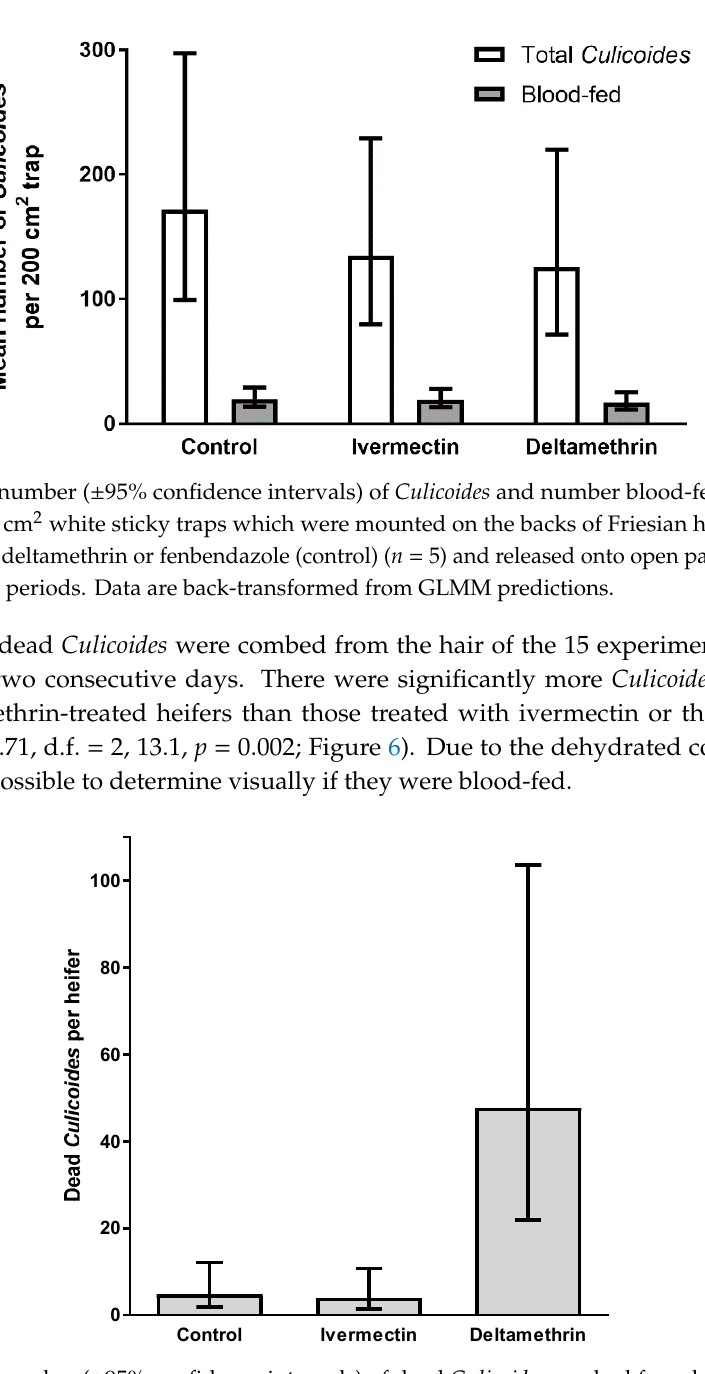
8 of 13 Figure 4. Mean number (±95% confidence intervals) of Culicoides and number blood-fed (grey bars) captured on 200 cm 2 white sticky traps mounted on the backs of Friesian heifers, treated with ivermectin and fenbendazole (control) ( n = 10) and released onto open pasture for 24 h. Data are back- transformed from GLMM predictions. 3.3. Trial 3— Culicoides’ Landing, Blood-Feeding and Mortality on Friesian Heifers Treated with Deltamethrin and Ivermectin Pour-Ons A total of 19,720 Culicoides (a maximum of 641 on a single trap) were caught on sticky traps on